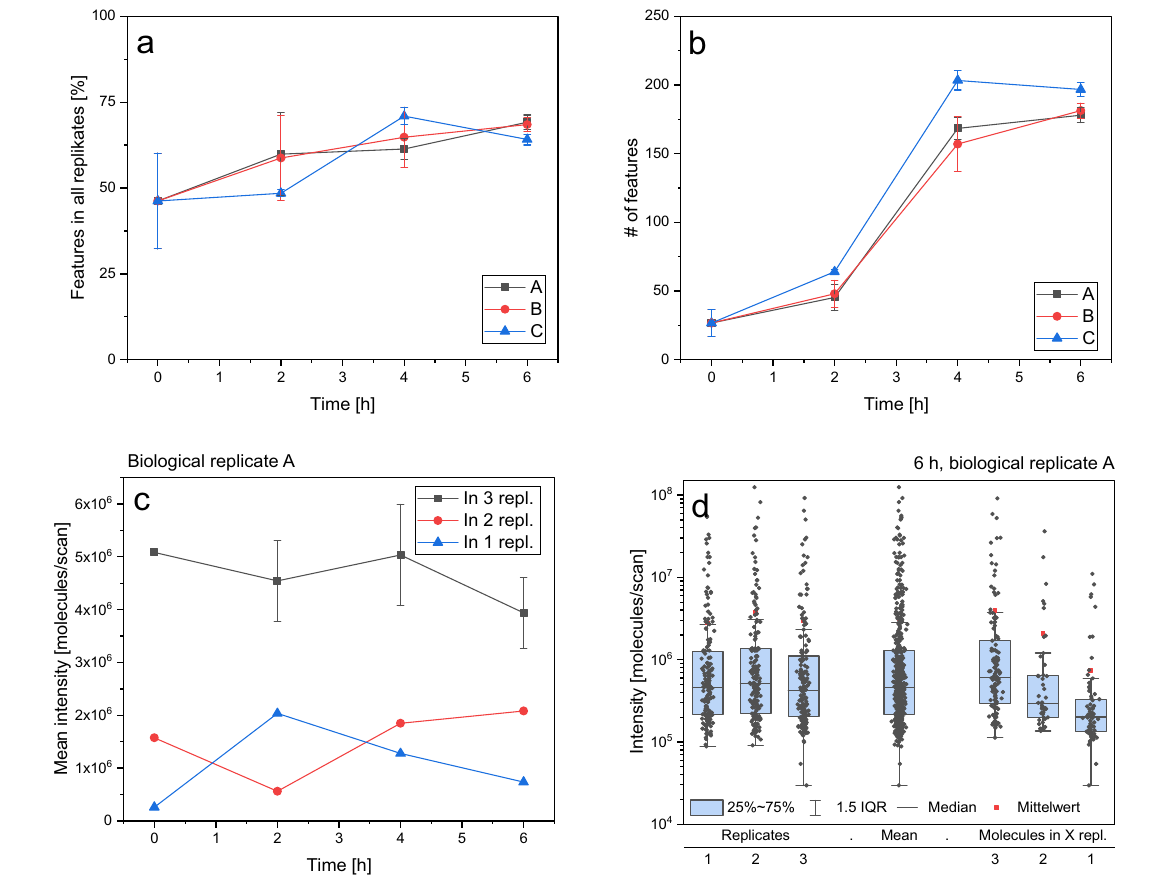
Figure 2. Number of identified volatiles over a growing yeast culture in shake flasks over time, presented are means and SD for n = 3 technical replicates ( a ) Percentage of features that are present in all replicates over time ( b ). Mean intensity of features present in one, two, or all three triplicate runs for shake flask A, error bars just for those n = 3 ( c ). Intensity on a logarithmic scale of every feature in shake flask A at 6 h (left), grouped whether the features are present in one, two, or all three replicate runs (right) ( d